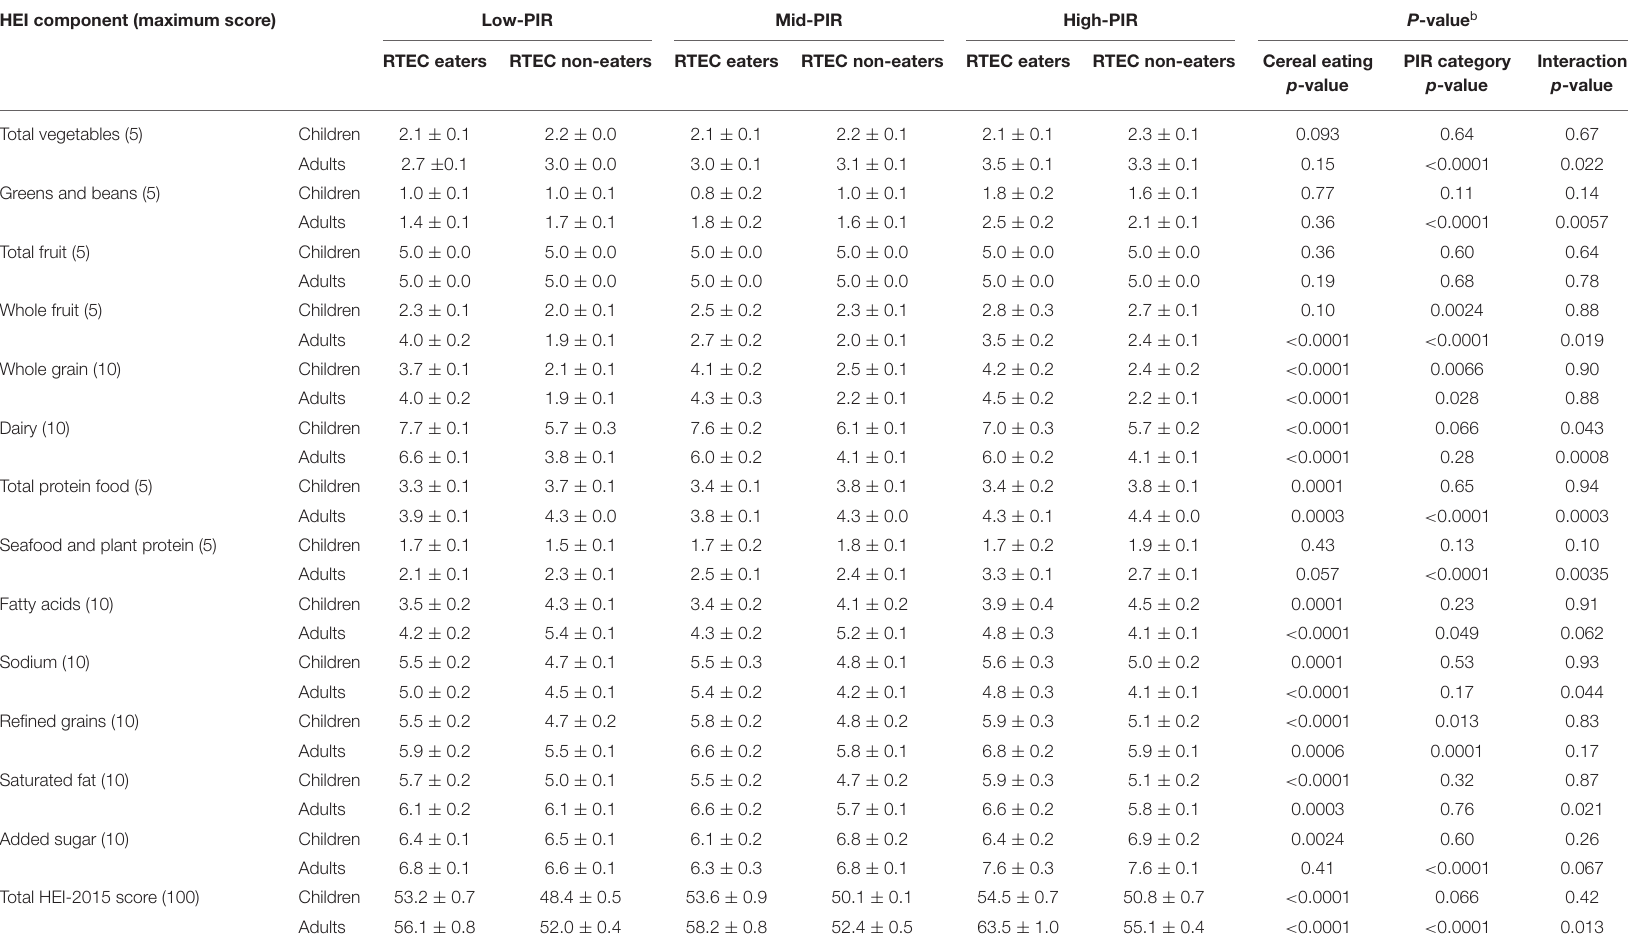
TABLE 4 | Healthy Eating Index total score and subcomponents for children and adults by ready-to-eat cereal consumption and poverty-to-income ratio status, National Health and Nutrition Examination Survey, 2015–2018 a . HEI component (maximum